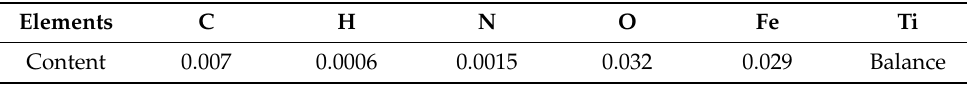
Table 1. Chemical composition of TA1 titanium plate (wt.